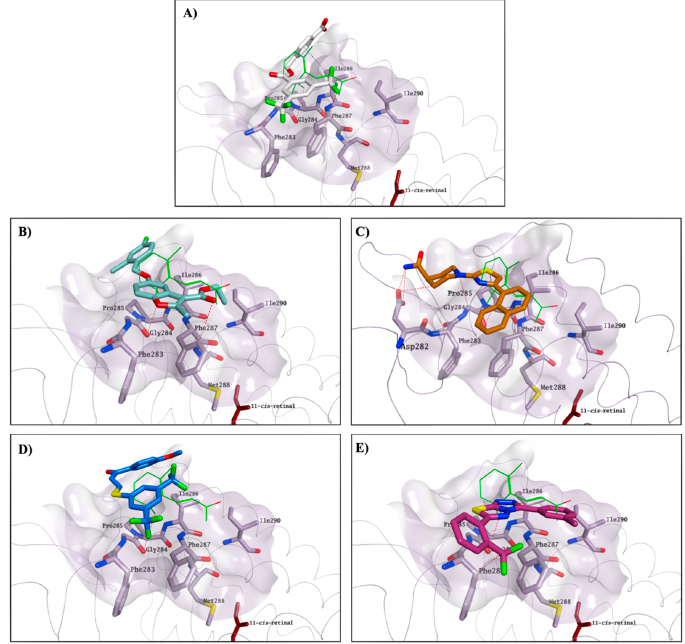
Figure 12. Potential binding mode for CF35EsC (carbon atoms in white; ( A )), 4 (carbon atoms in teal; ( B )), 7 (carbon atoms in orange; ( C )), 13 (carbon atoms in blue; ( D )) and 22 (carbon atoms in red violet; ( E )) to the secondary hydrophobic pocket. β -Ionone carbon atoms are in green, whereas 11- cis -retinal carbon atoms are garnet. The binding site area is represented as the molecular surface. Rhodopsin is represented as a lilac tube for clarity. Molecules 2020 , 25 , x FOR PEER REVIEW